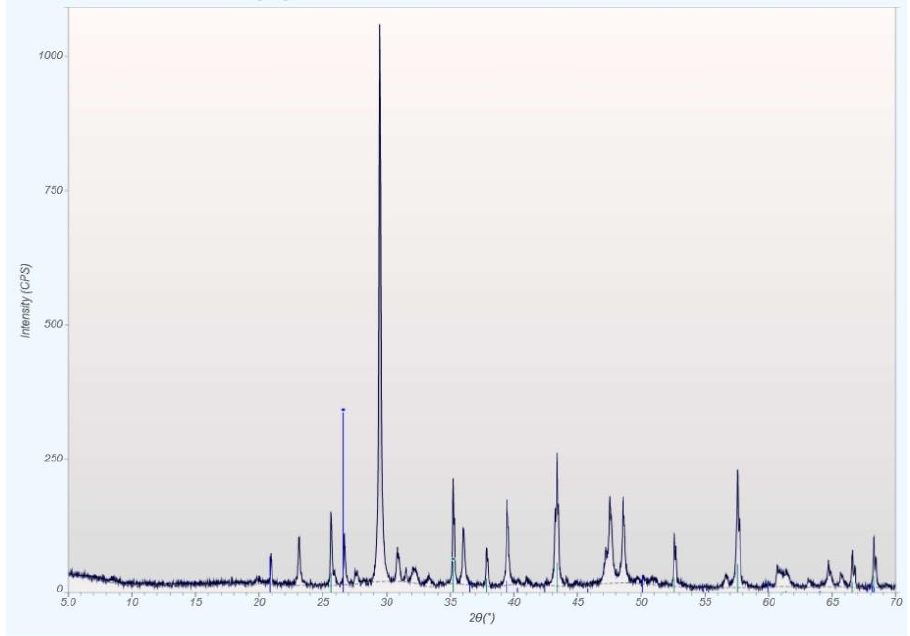
Figure D3. qXRD spectra for the bituminous limestone marl sample OS-3.